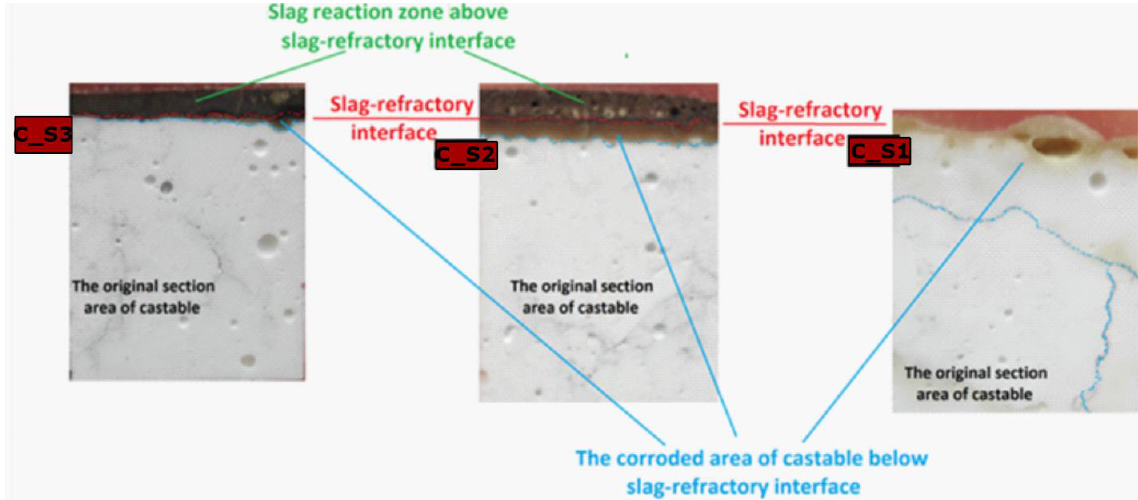
Figure 10. Schematic showing the division into reaction zones in materials.